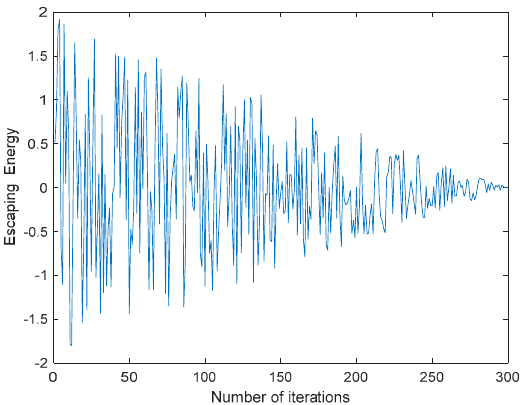
Figure 1. An illustration of escaping energy.